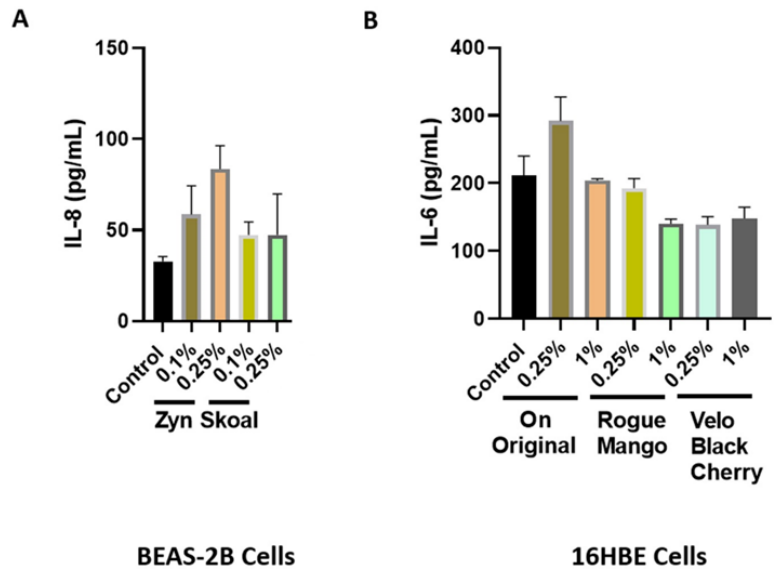
Figure 8. Inflammatory mediator response due to flavoring nicotine oral products in bronchial epithelial cells . ( A ) BEAS-2B cells were treated with spearmint-flavored nicotine pouches from Zyn and Skoal brands. Following 24 h exposure, conditioned media was used for IL-8 measurements. ( B ) 16HBE cells were treated with different oral nicotine pouch flavors ON! original, Rogue mango, for IL-6 measurement. Results are represented